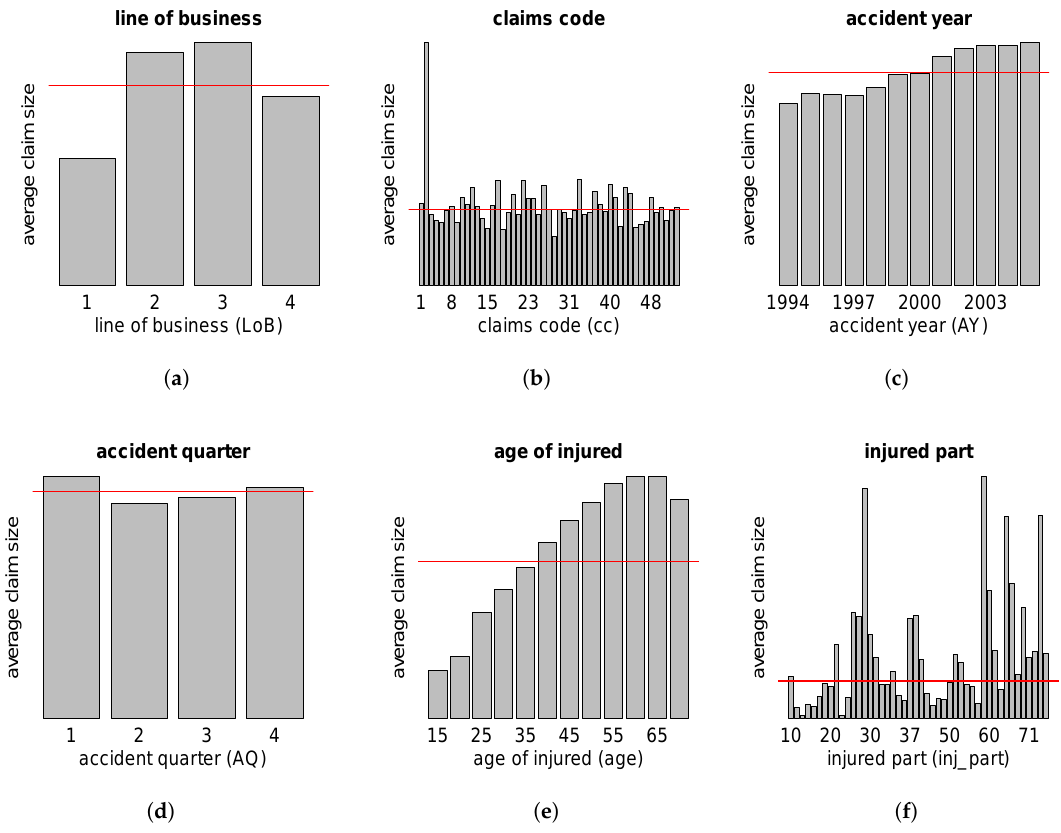
Figure A4. Average claim size w.r.t. the features ( a ) LoB ; ( b ) cc ; ( c ) AY ; ( d ) AQ ; ( e ) age and ( f ) inj_part ; the red lines show the